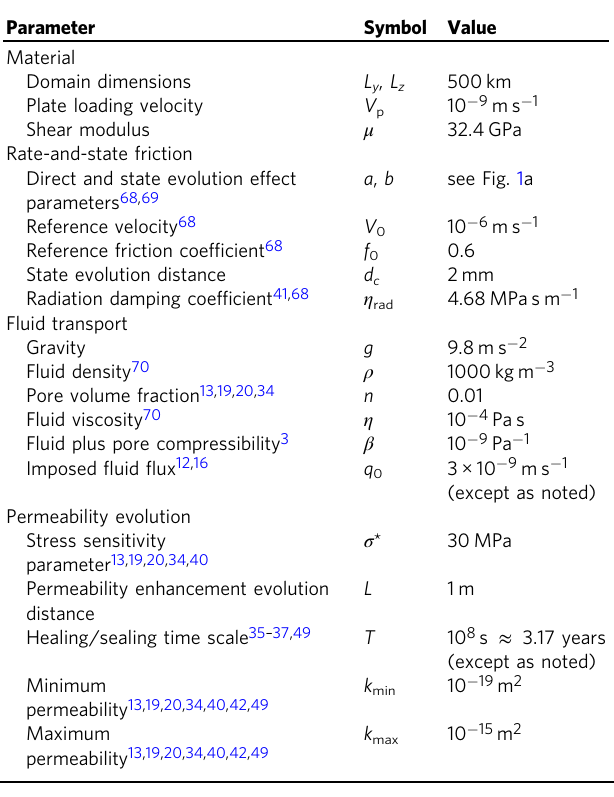
Table 1 Model parameters and associated references for parameter